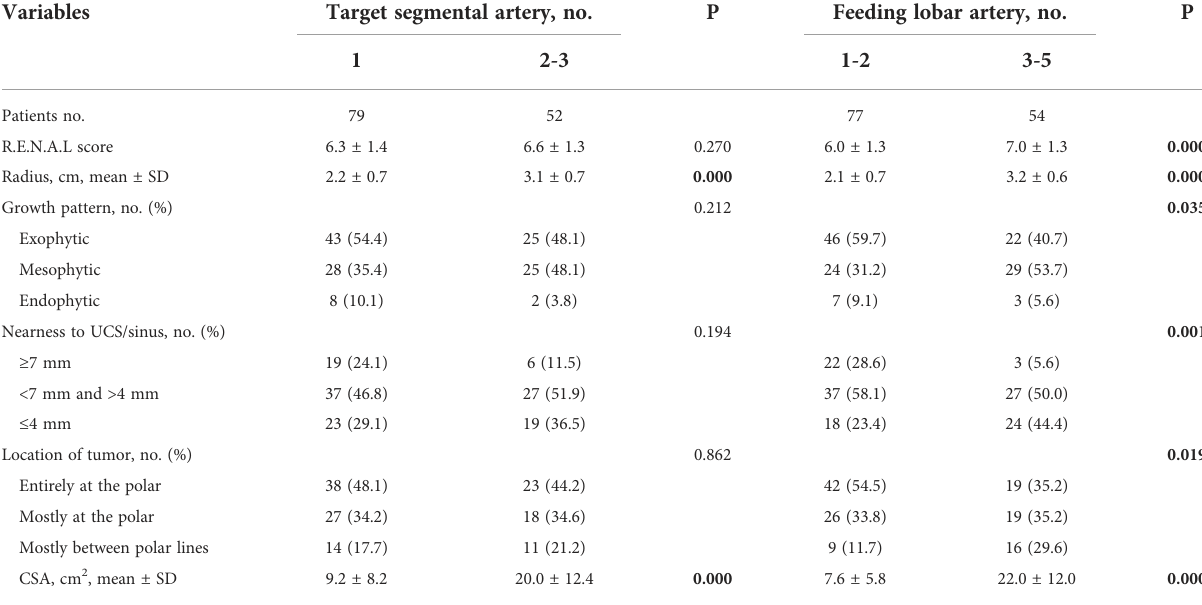
TABLE 4 Relationship between the tumor characteristics and the number of feeding arteries. Variables Target segmental artery, no. Feeding lobar artery,